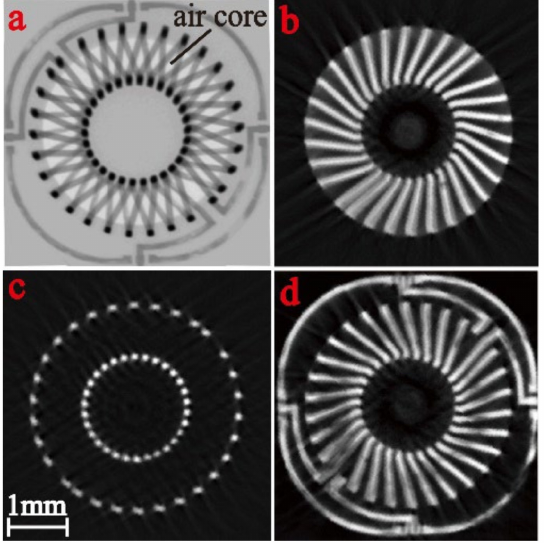
Figure 9. X-ray microscope view of a toroidal transformer. ( a ) Superposition of field of views in thickness direction ( t direction). Views of the cross-section ( b ) 50 µ m; ( c ) 500 µ m; and ( d ) 950 µ m from the